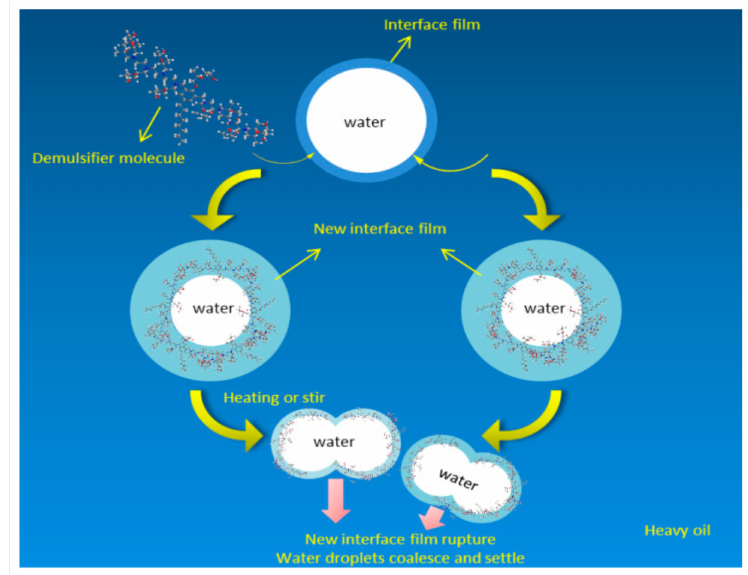
Figure 22. Demulsification mechanism of